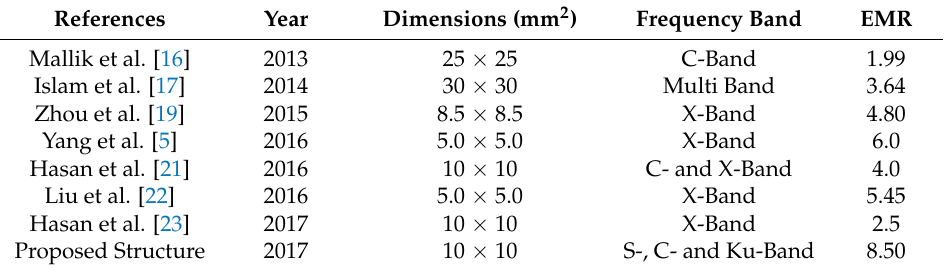
Table 8. Performance comparison of the proposed meta-atom with the reported previous research.